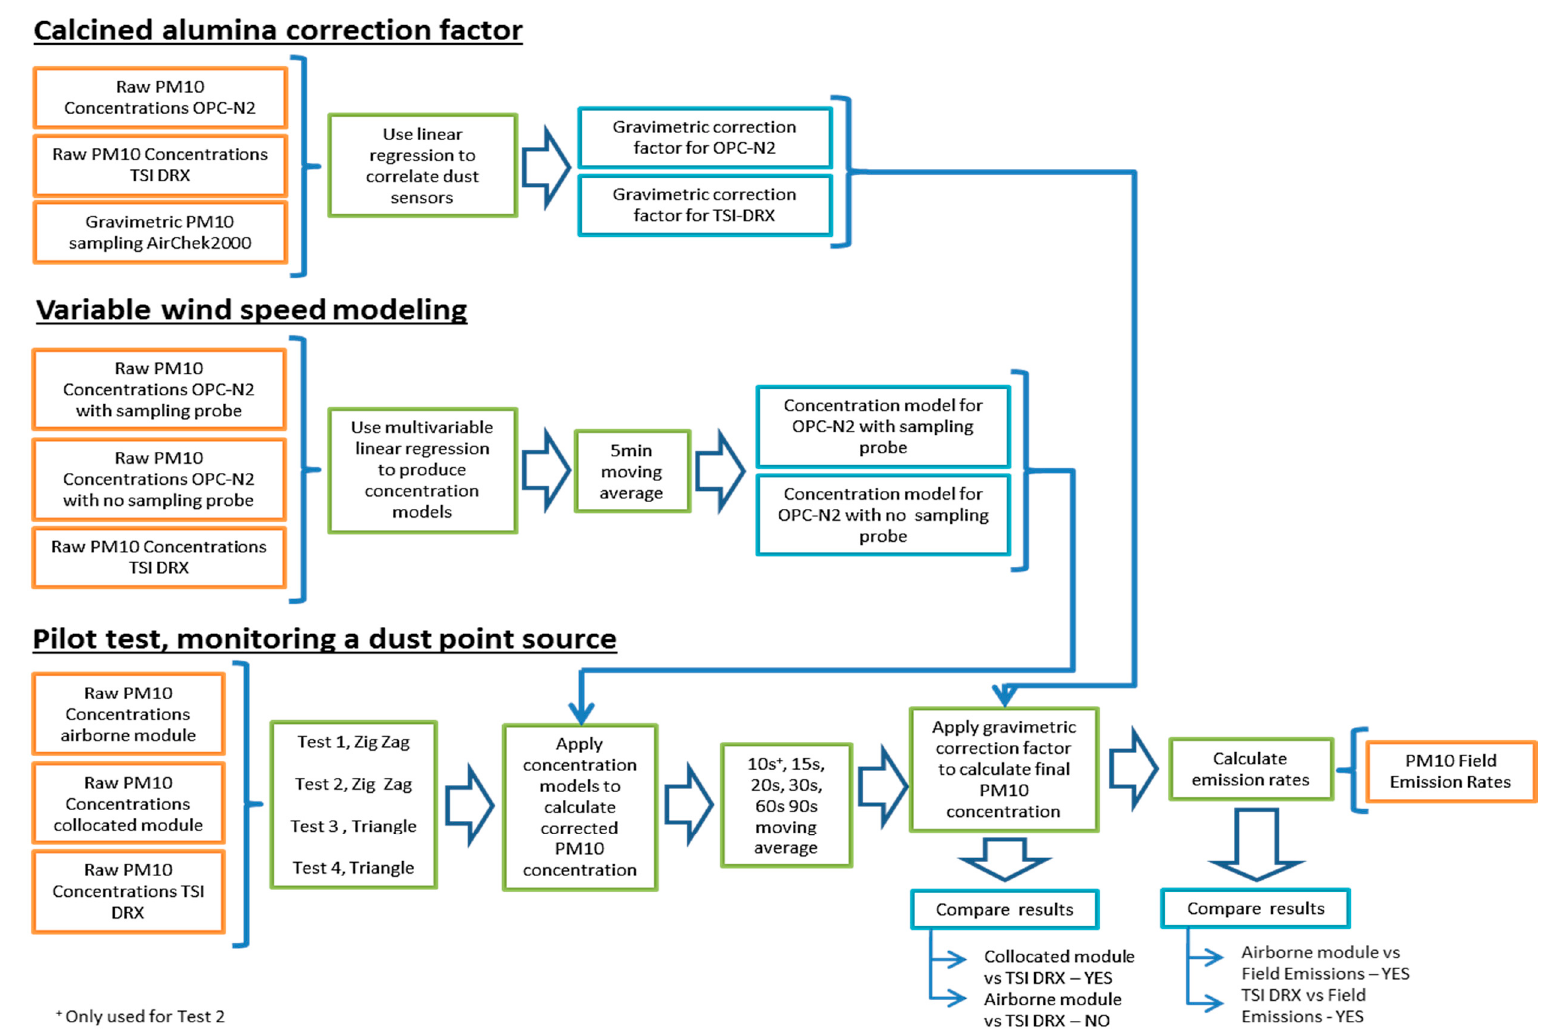
Figure 8. Flow diagram summarizing tests undertaken to validate readings collected with the dust monitoring sensors.